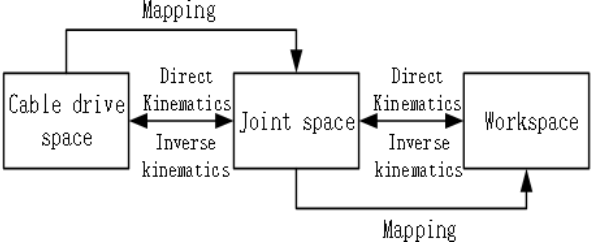
Figure 1. Mapping relationship of the workspace for a hyper- redundant manipulator driven by cables.